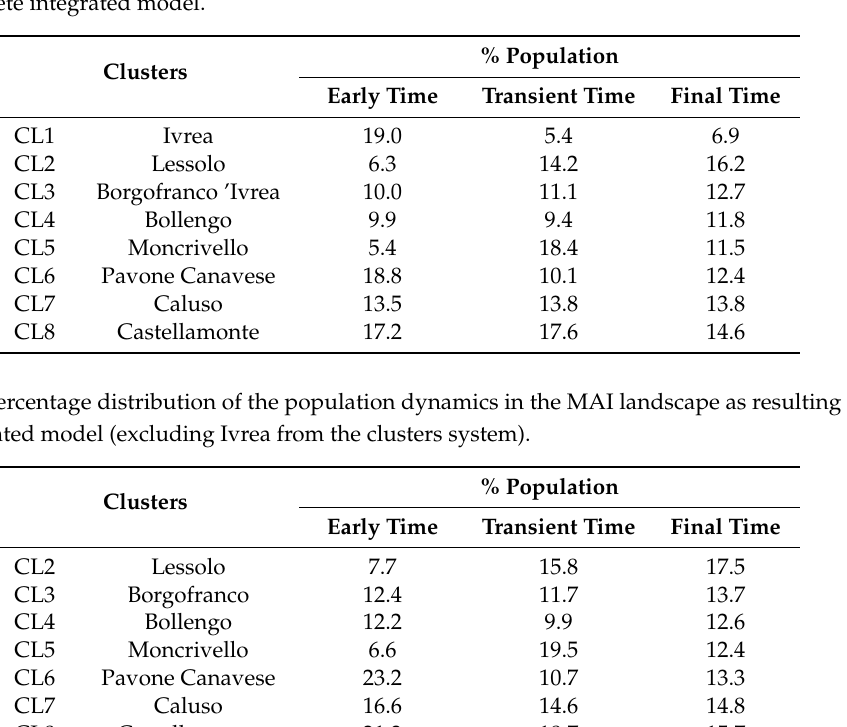
Figure 5. Simulation of the population mobility before ( a ) and after ( b ) the exclusion of the cluster of Ivrea from the MAI clusters system. Table 7. Percentage distribution of the population dynamics in the MAI landscape as resulting from the complete integrated model.